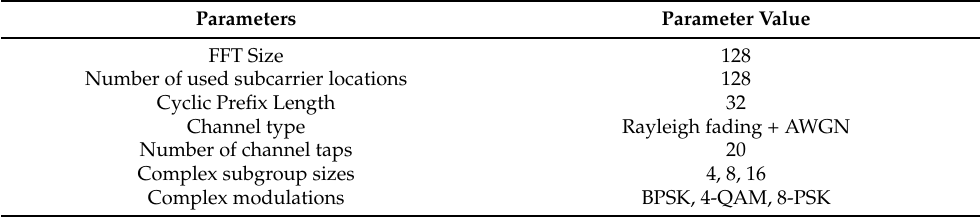
Table 6. The simulation